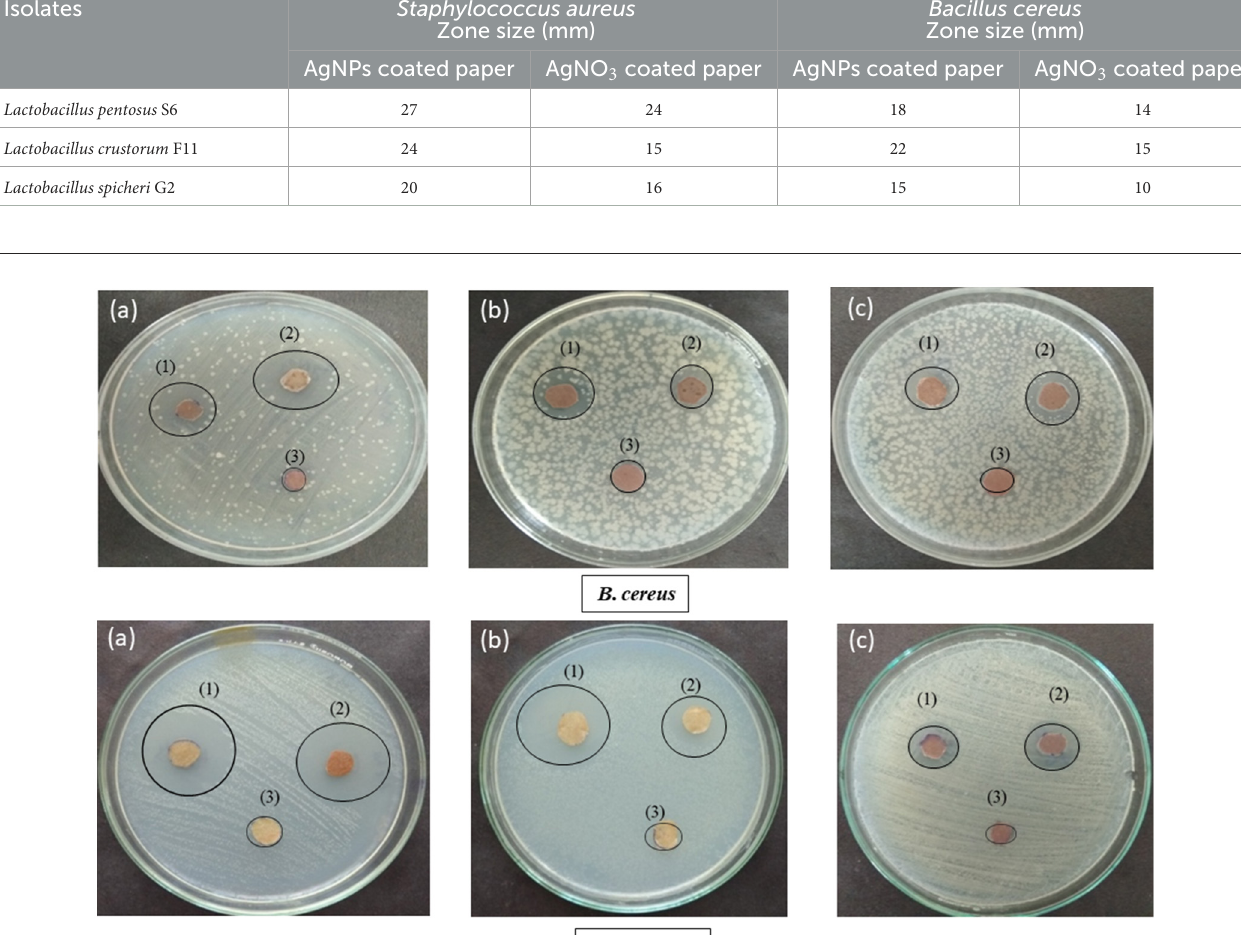
action of bacteriocin against spoilage-causing